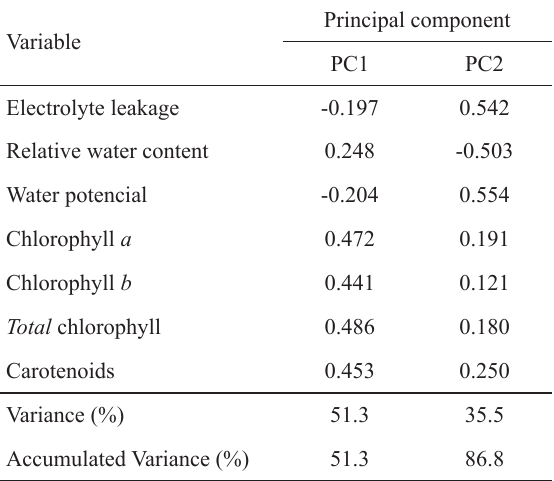
Correlation coefficients between the principal components (PC1 and PC2) and the physiological characteristics of the safflower lines (IMA 02, IMA 04, IMA 10, IMA 14, IMA 16 and IMA 21) for three evaluation periods: before water deficit, after 30 days of water deficit and after 18 days of